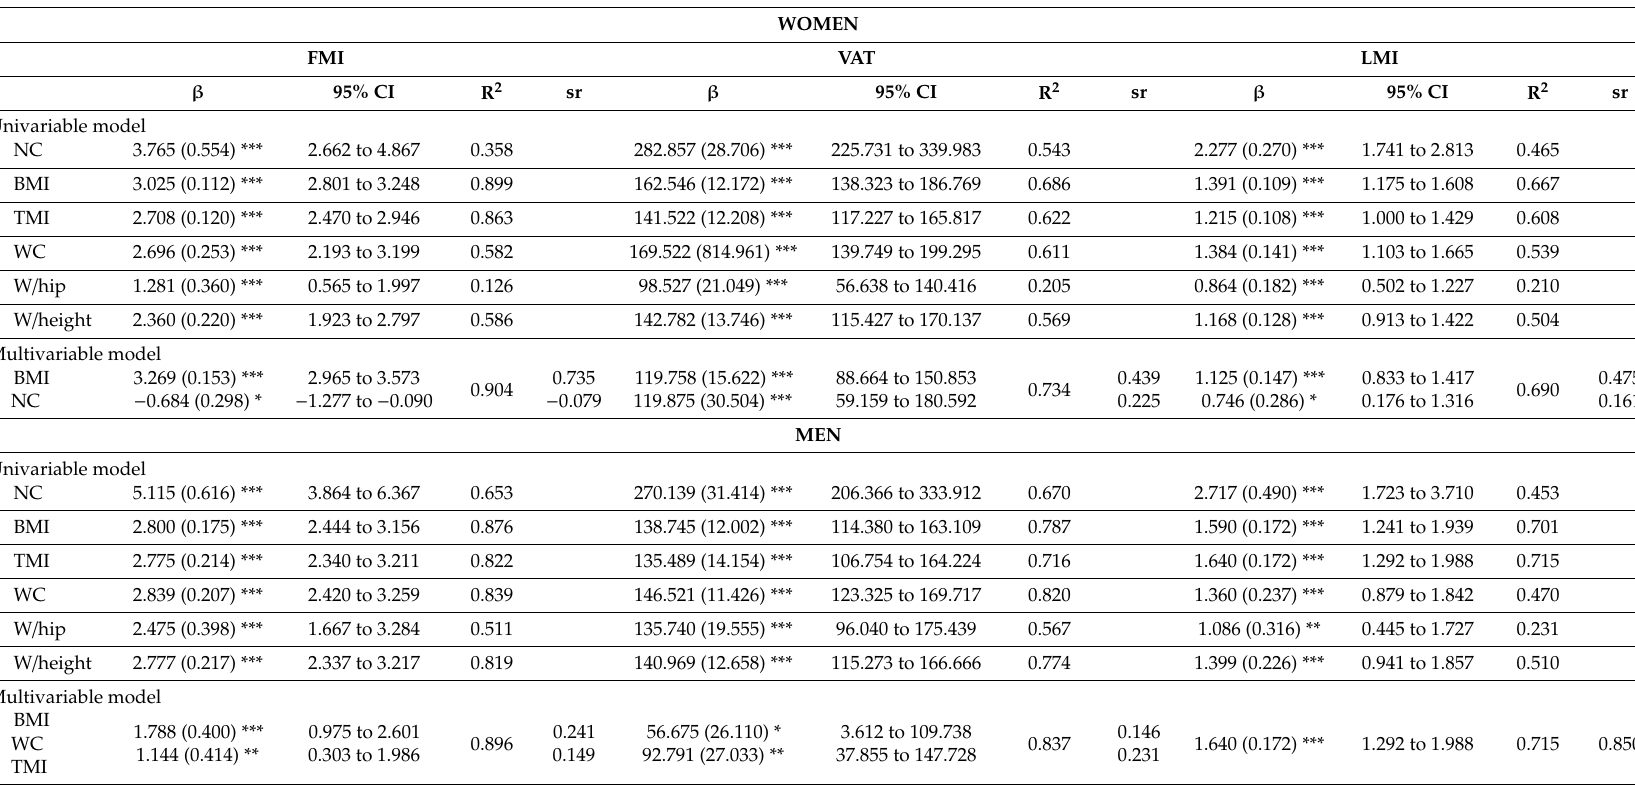
Table 2. Association of neck circumference, body mass index, triponderal mass index, waist circumference, waist to hip ratio and waist to height ratio with body composition measured by Dual X-ray absorptiometry (DXA) in women (n = 82) and men (n =